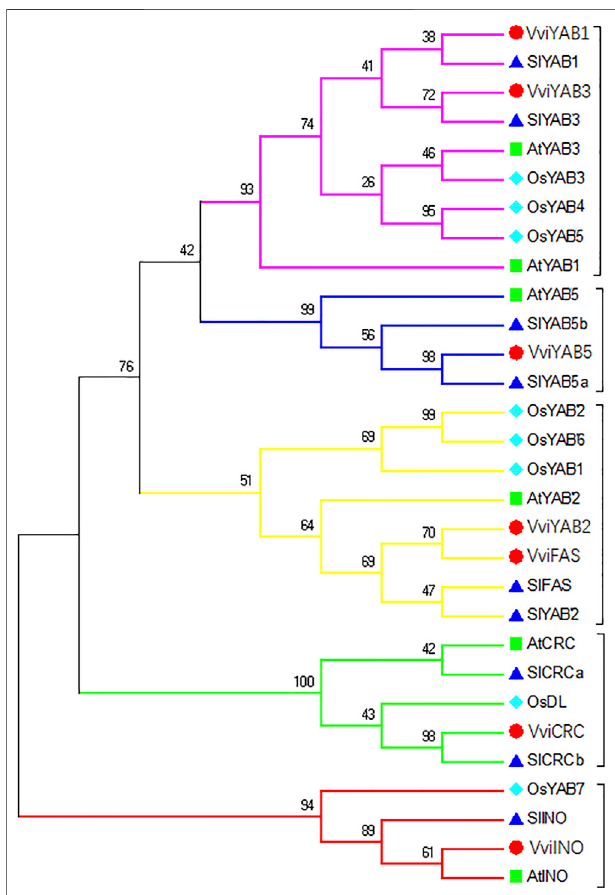
FIGURE 1 | Phylogenetic relationships of YAB genes among four plant species. YABs were divided into fi ve subfamilies (YAB1/YAB3, YAB2, YAB5, CRC, and INO) The neighbor-joining method was used, and the bootstrap values were set at 1,000.